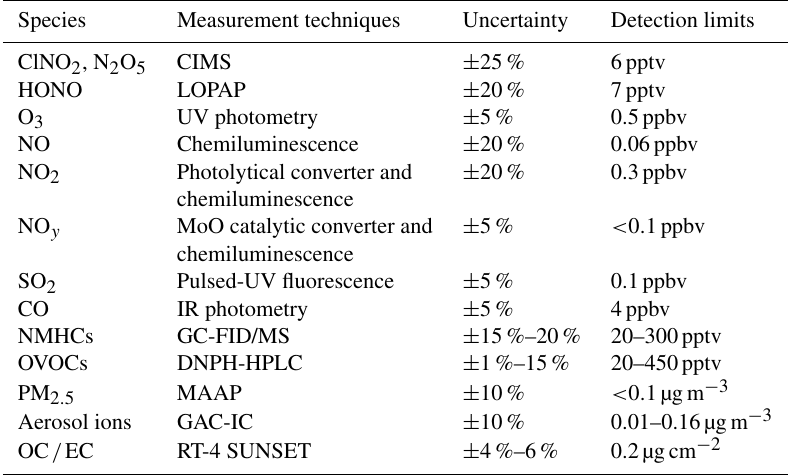
Table 1. Technique, limit of detection, and uncertainty of measuring instruments for trace gases and aerosols.